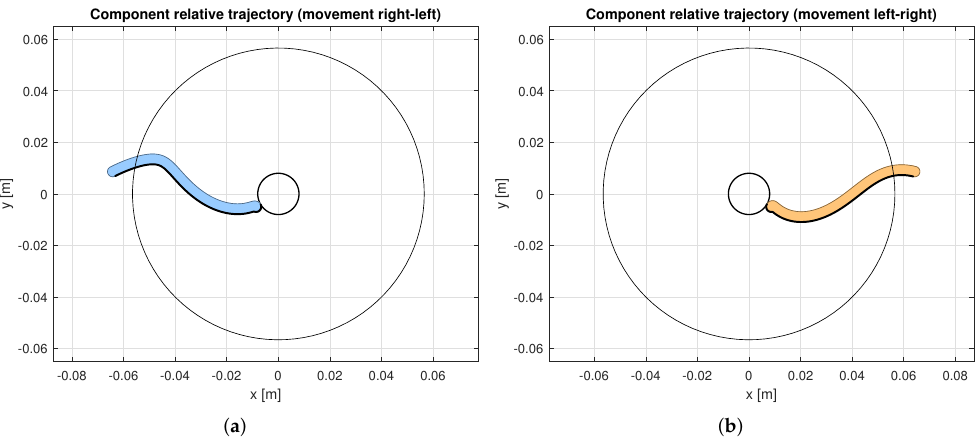
Figure 6. Shape of the two blades -left ( a ) and right ( b )- for the two compartments. Please note that the shape of the blade pierces the cylinder walls since in the movement time T the component is able to fall outside of the cylinder via free fall.